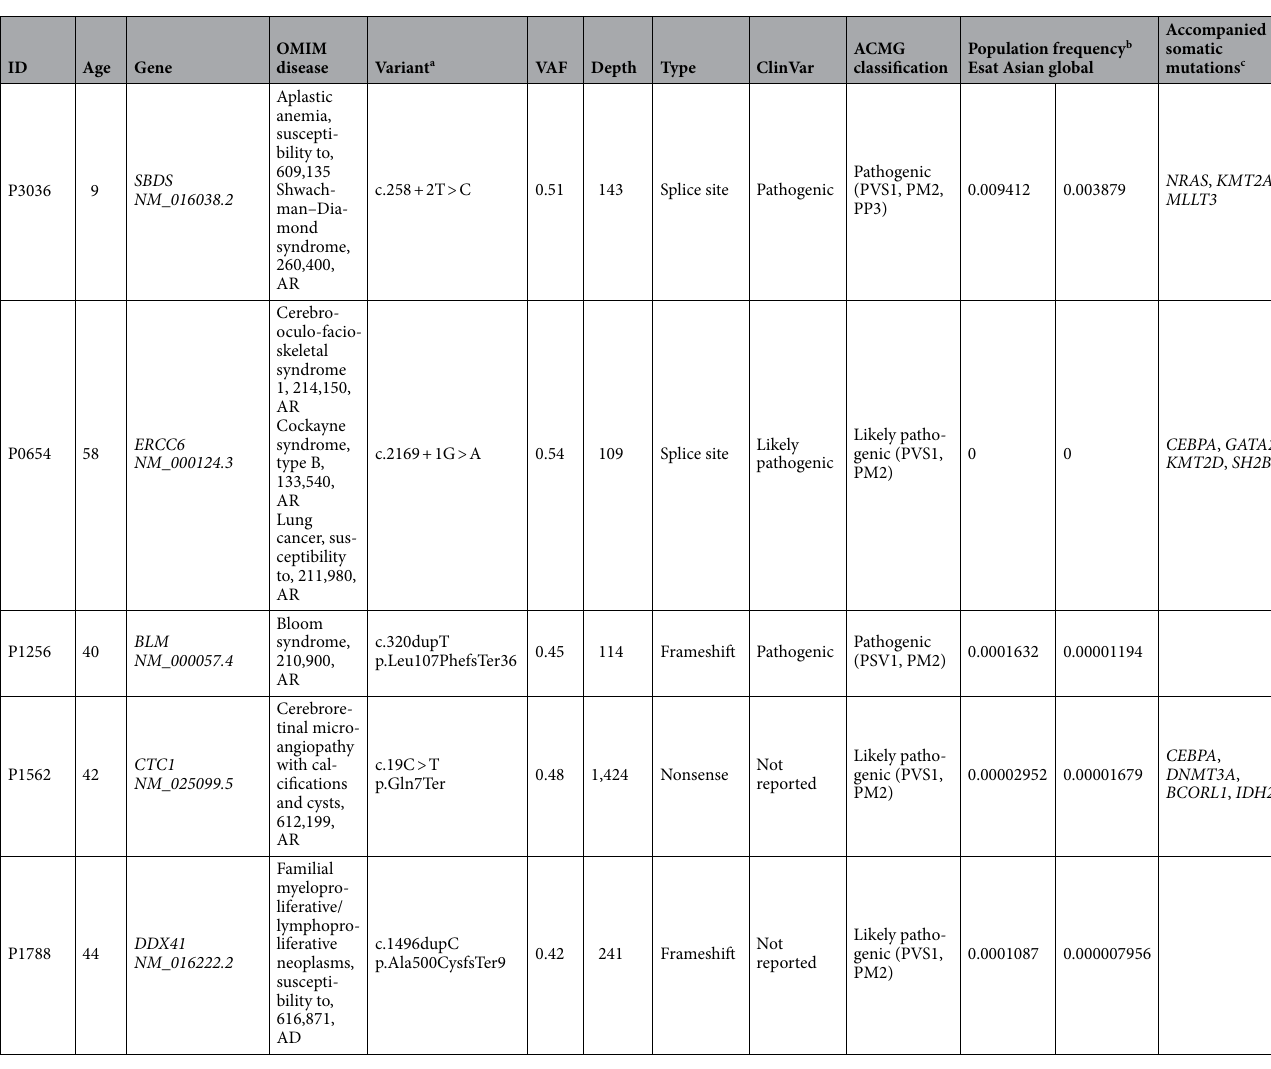
Table 1. Identified germline predisposition gene mutations. VAF variant allele fraction, ITD internal tandem duplication, PTD partial tandem duplication, VOUS a variant of unknown significance. a Variants were confirmed as germline origin using bone marrow aspirate in complete remission. b Population frequencies from gnomAD (https ://gnoma d.broad insti tute.org/). c Tier 1 or Tier 2 somatic variants according to published guideline (Li et al., J Mol Diagn 2017, PMID 27993330) were